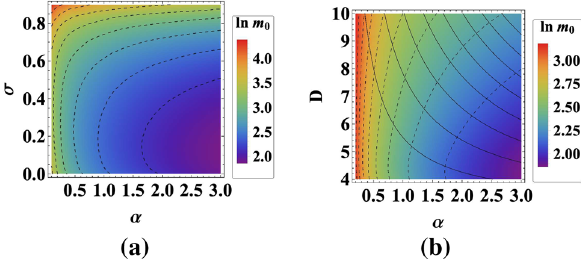
Fig. 9 Plots of the string mass density (73). a The String mass density m 0 in the parameter space ( α , σ ) in the limit D → 4. b The string mass density m 0 in the parameter space ( α , D ) with σ = 1 / 10. Each dashed curve has the same value of mass density. And each solid curve corresponds to the same metric solution